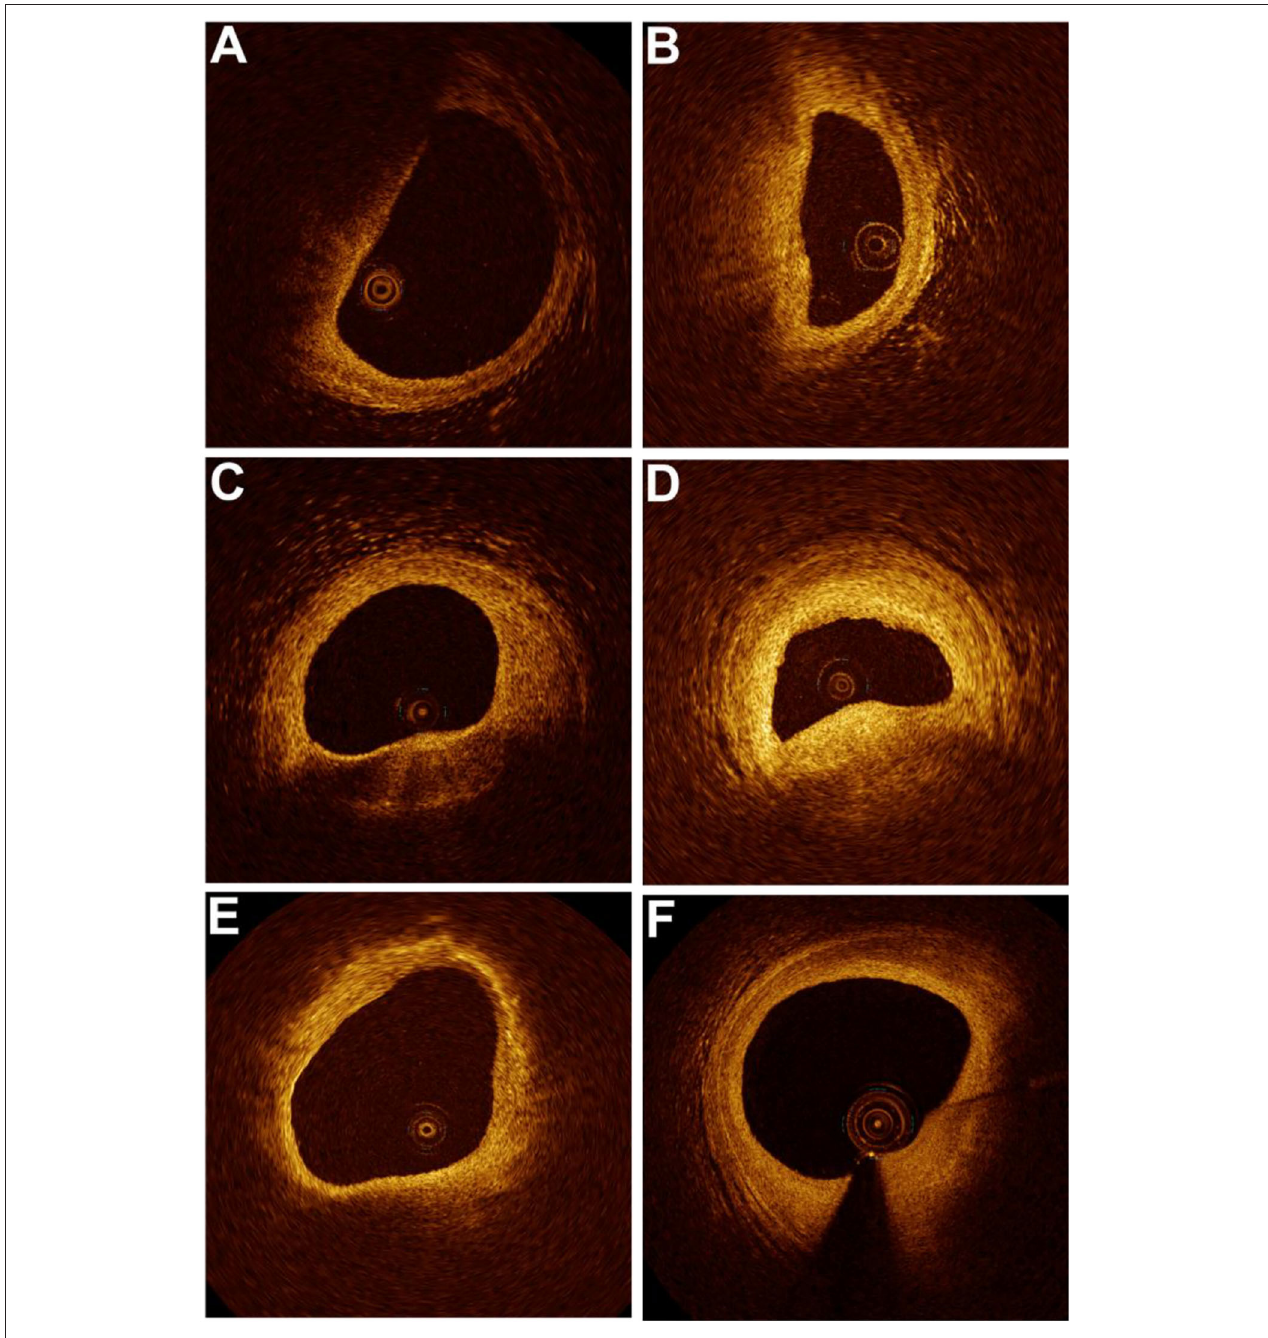
FIGURE 3 | Changes in plaque characteristics for each group at baseline and 1-year follow-up. In the persistent smoking group, the fibrous cap thickness (FCT) was 0.05mm with a lipid arc of 117.9 ◦ at baseline (A) and 0.08mm with a lipid arc of 161.5 ◦ at the 1-year follow-up (B) . In the smoking cessation group, the FCT was 0.04mm with a lipid arc of 138.3 ◦ at baseline (C) and 0.11mm with a lipid arc of 95.7 ◦ at the 1-year follow-up (D) . In the nonsmoking group, the FCT was 0.11mm with a lipid arc of 235.7 ◦ at baseline (E) and 0.25mm with a lipid arc of 157.3 ◦ at the 1-year follow-up (F) .